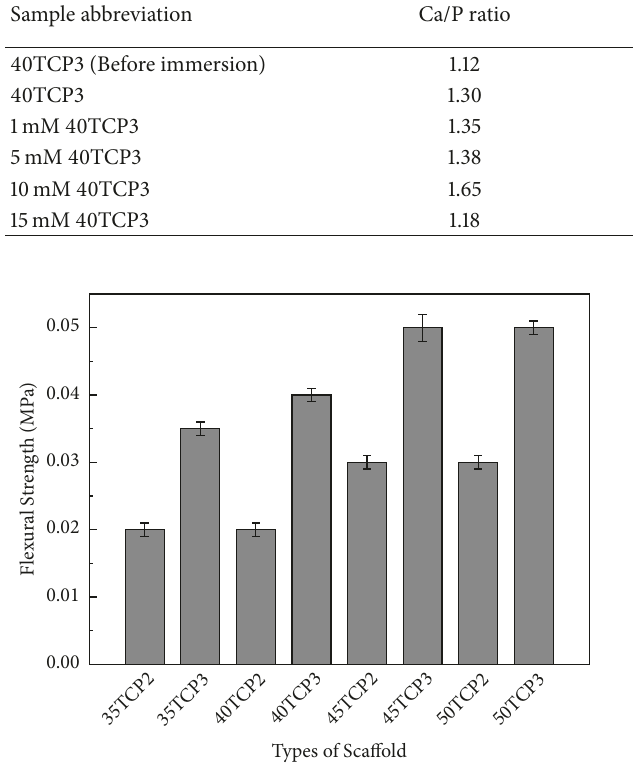
Figure 4: Flexural strength of 𝛽 -TCP scaffold with concentration and coating times. Error bar represents mean ± Standard Deviation (SD); 𝑛 = 5